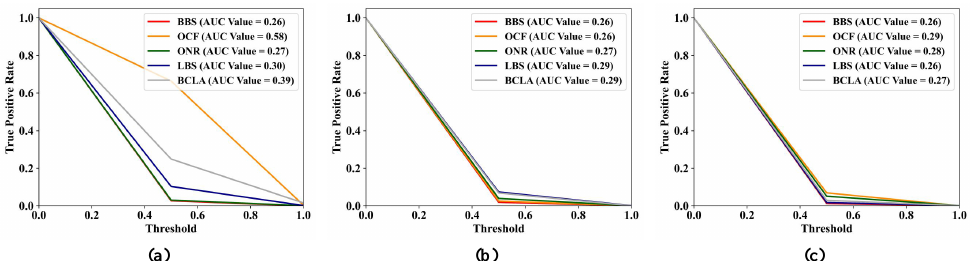
Figure 18. The ROC of ( P F , Threshold ) for the UTD results on the Nano-Hyper data set with different band selection methods. The number of selected bands is ( a ) 22, ( b ) 34, ( c ) 58.